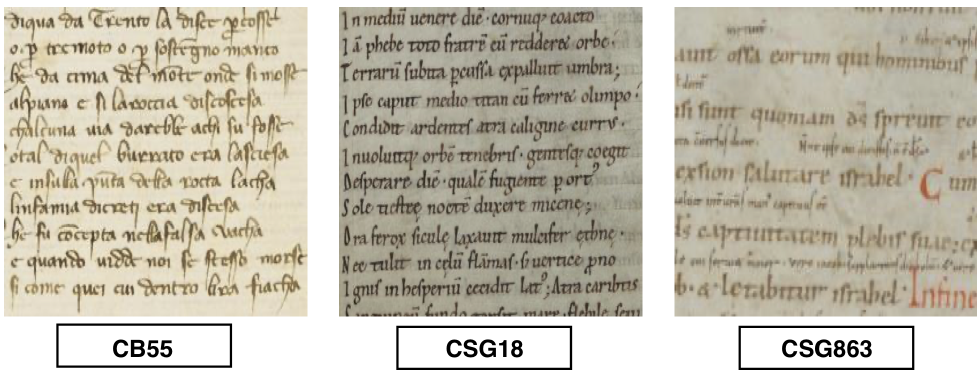
Figure 8. An example of patch from each collection in the Diva-HisDb